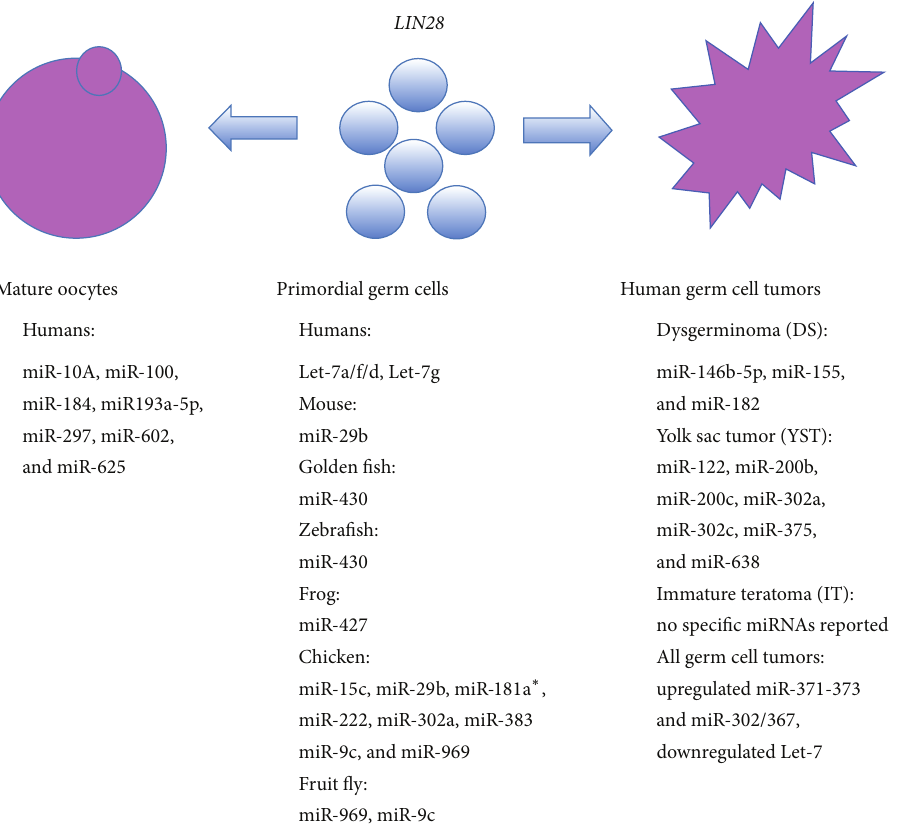
Figure 1: Most expressed miRNAs in primordial germ cells [10–19], germ cell tumors [24], and human oocytes [28, 29]. MiR-29b and miR-430 are overlapping between different vertebrate species. MiR302a, upregulated, and Let-7, downregulated, in germ cell tumors are overlapping with miRNAs identified in vertebrate PGCs. The expression of gene LIN28 is essential during normal germ cell development for PGC specification. Tumor-suppressor Let-7 miRNA family is downregulated in malignant germ cell tumors because of abundant expression of the regulatory gene LIN28